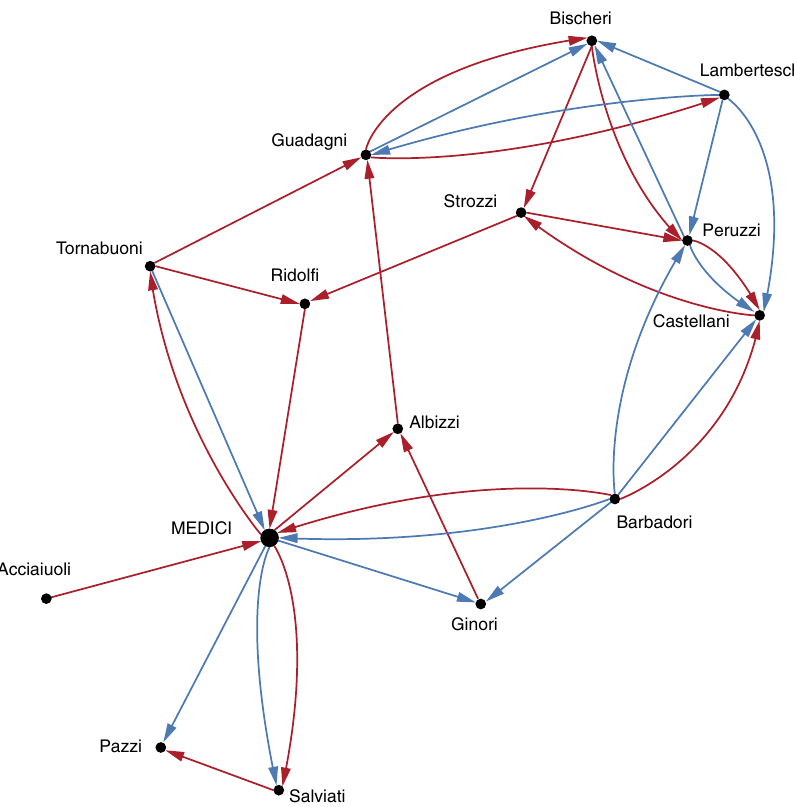
Fig. 6 Multiplex graph of marriages (red) and business (blue) relations between 15 Florentine families. The adjacency matrix of the combined network is constructed as the maximum between the adjacency matrices that correspond to the marriage and the business